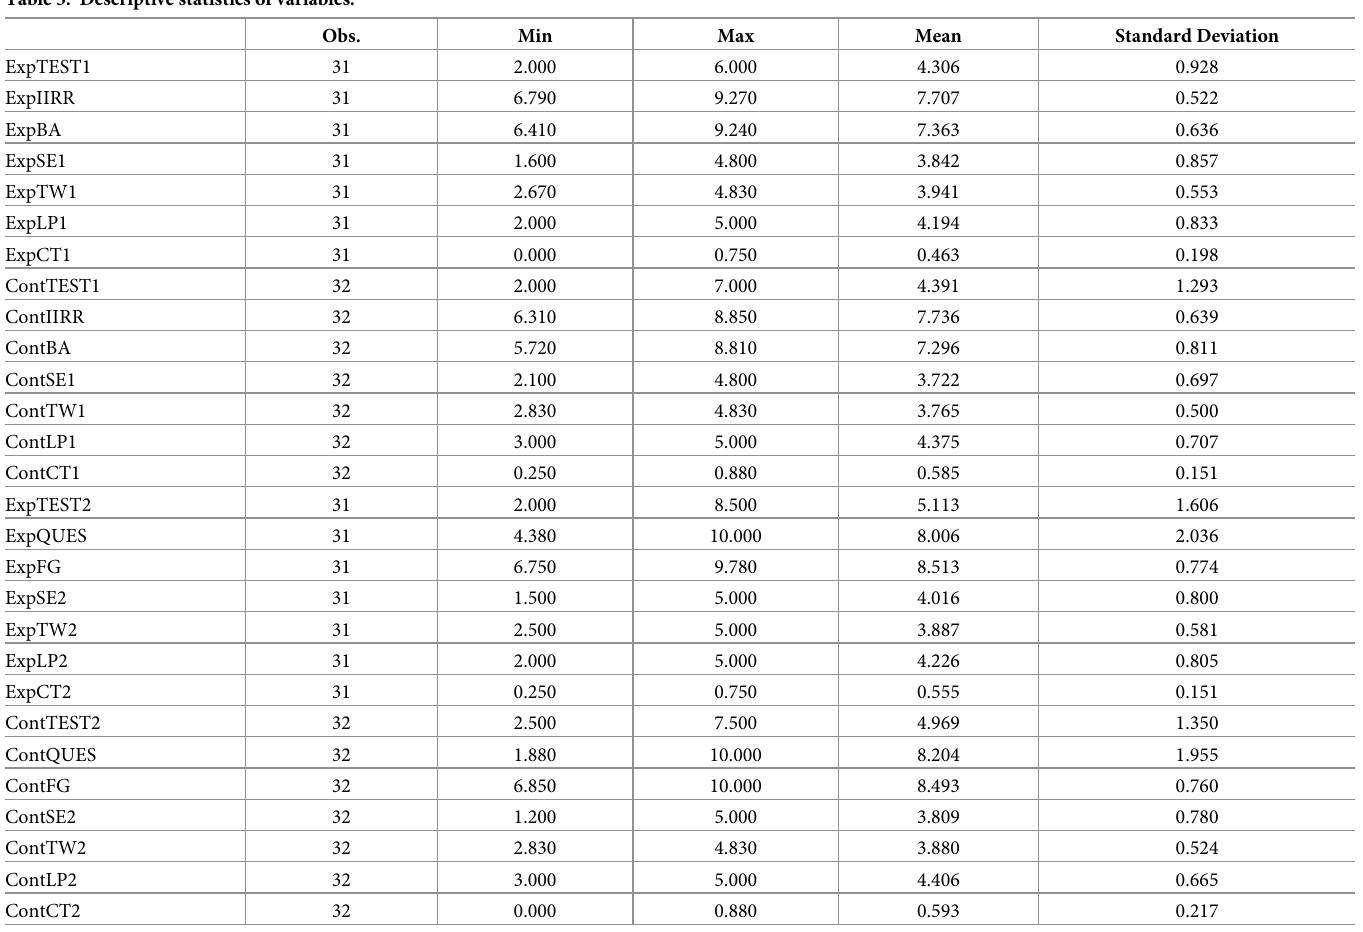
Table 3. Descriptive statistics of